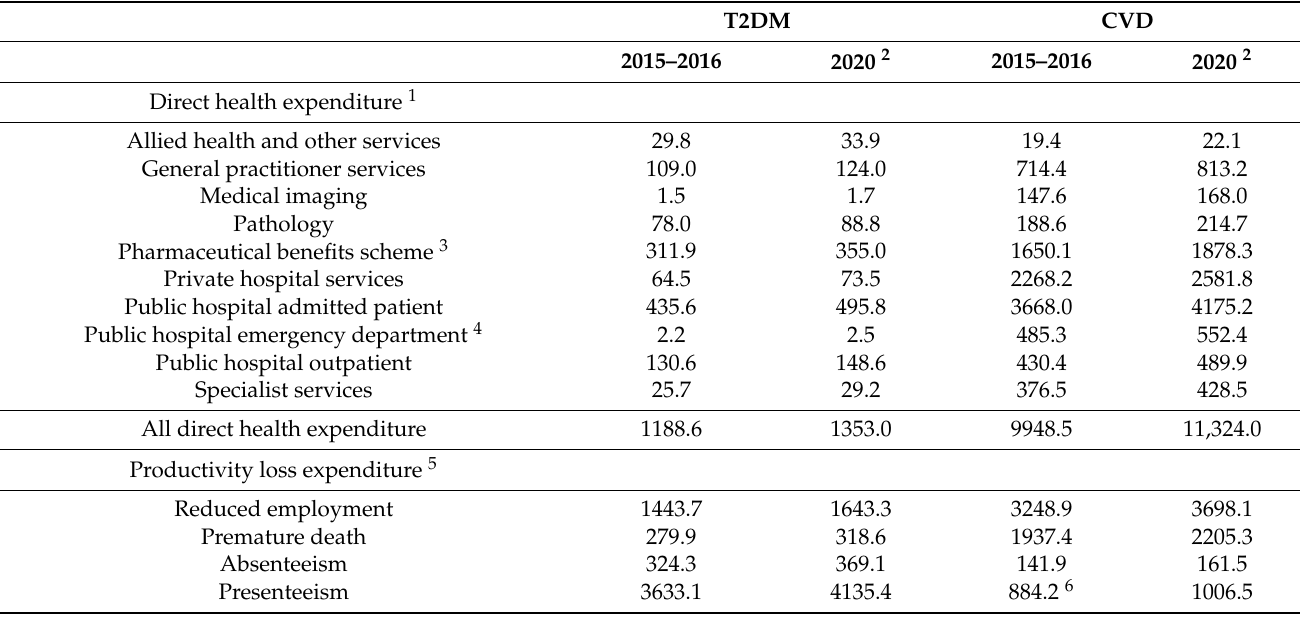
Table 2. Summary of Type 2 Diabetes Mellitus and cardiovascular disease direct health and productivity loss expenditures in Australia (AUD million), age 20 and